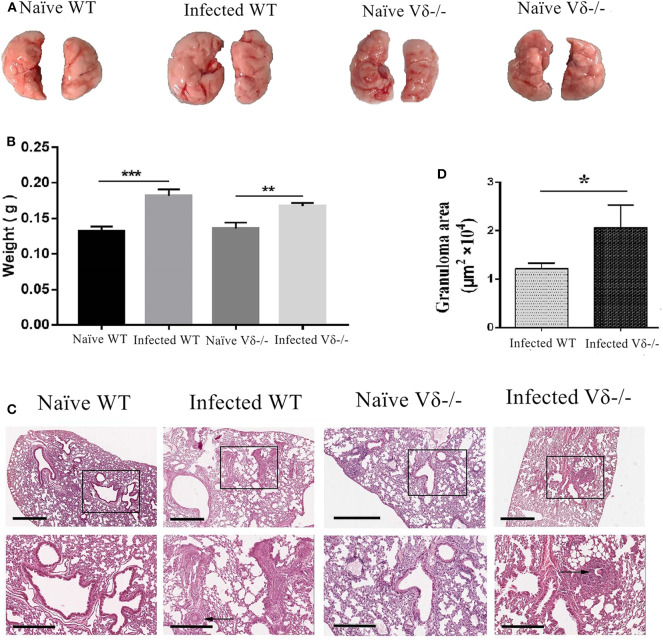
Pathological changes in the lung of infected Vδ−/− mice. C57BL/6 and Vδ−/− mice were infected with 40 ± 5 S. japonicum cercariae per mouse. Five to six weeks after infection, mice were euthanized. (A) Lung appearance in naïve and infected WT and Vδ−/− mice was compared. (B) The weight of the lung from naïve and infected WT and Vδ−/− mice was compared. (C) Hematoxylin and eosin staining were performed on paraffin sections of lung tissue. Scale bar, 600 μm (upper), 300 μm (lower). (D) The area of granuloma in infected WT and Vδ−/− mice was compared. A representative of three independent experiments with 5–6 mice per group is shown. The error bars are SD, *P < 0.05, **P < 0.01, ***P < 0.001.